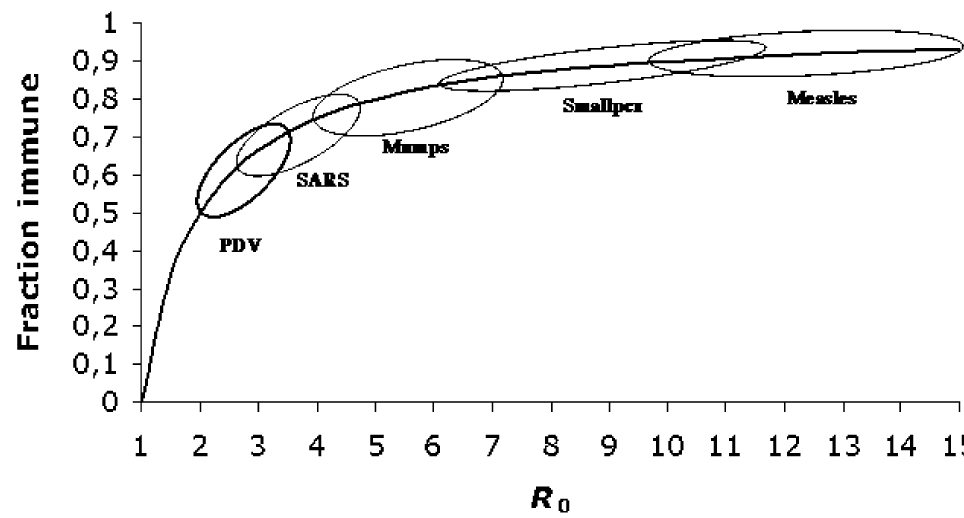
Fig. 1. Herd immunity levels for some common human epidemic diseases as compared with emerging diseases such as SARS and the phocine distemper virus (PDV). The curve is given by the function q c =1-(1/ R 0 ) (Anderson and May 1991), where q c is the critical herd immuni- ty level, and R 0 is the basic reproductive